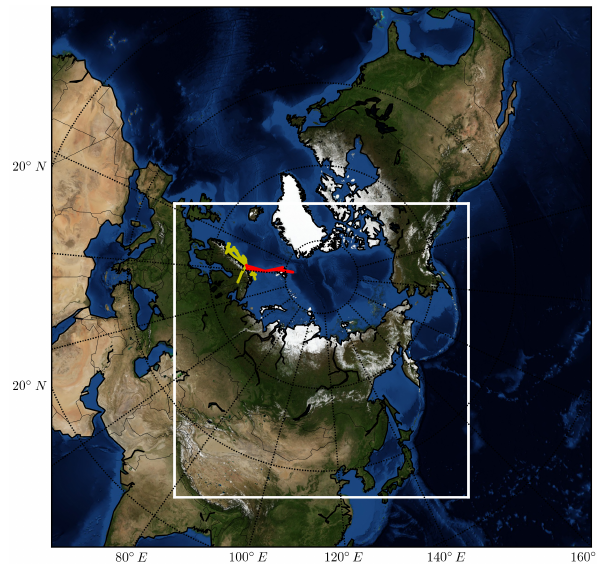
Figure 1. Map of the WRF-Chem domain (white) and the flights conducted as part of ACCESS used to evaluate the model. The Fal- con 20 flights are in yellow. Flights of 17 July are highlighted in